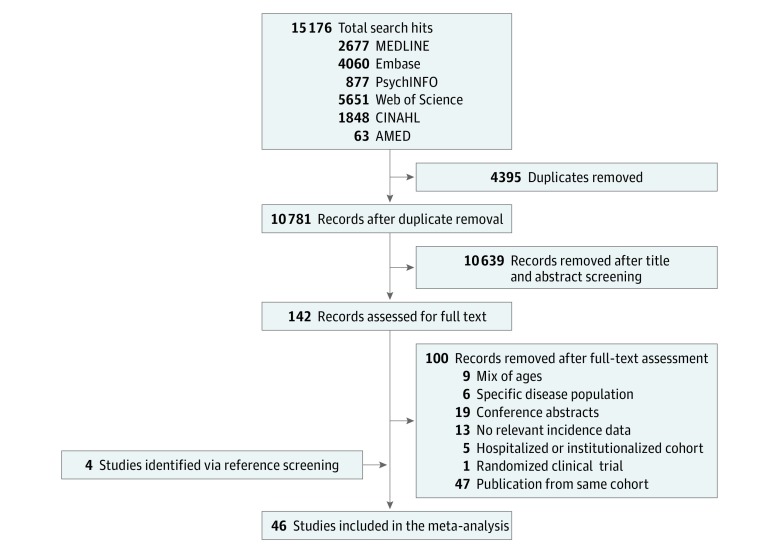
PRISMA Diagram of the Study Selection ProcessAMED indicates Allied and Complementary Medicine Database; PRISMA, Preferred Reporting Items for Systematic Reviews and Meta-analyses.